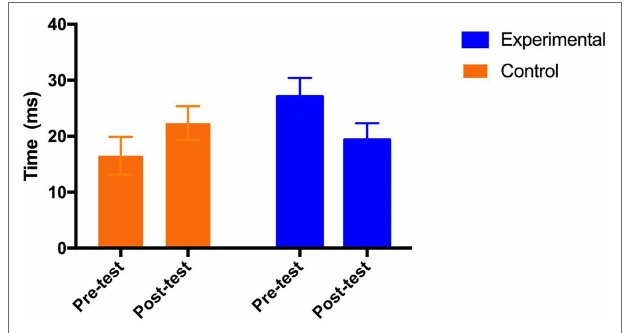
FIGURE 4 | Adjusted means (SEs) for alerting by group and test.